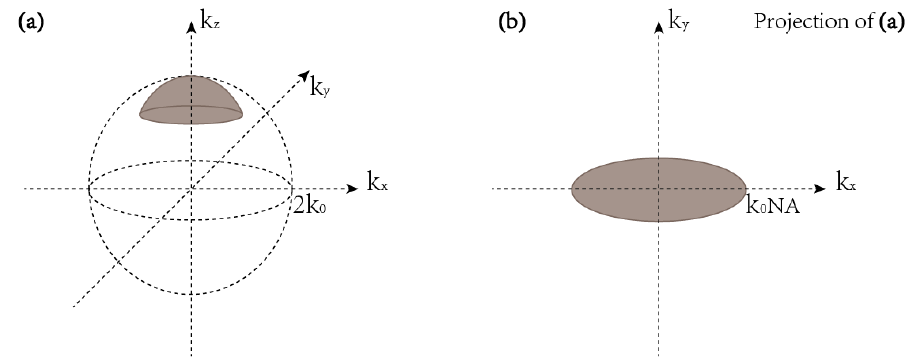
Figure 2. A description of the accessible frequency domain of conventional microscopy. ( a ) The sample is illuminated in normal incidence and detected in the same direction. ( b ) The projection of the measurable di ff racted wave vector k onto the transverse (x O y) in conventional